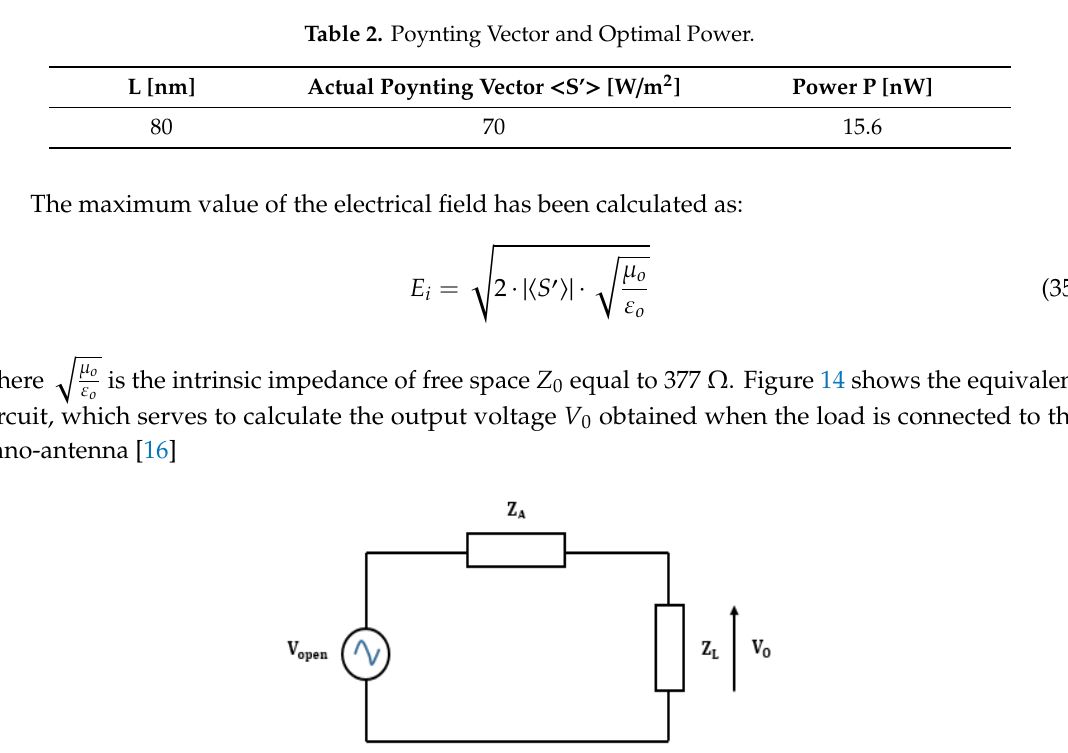
Figure 14. Equivalent circuit for the calculation of the output voltage V 0 .